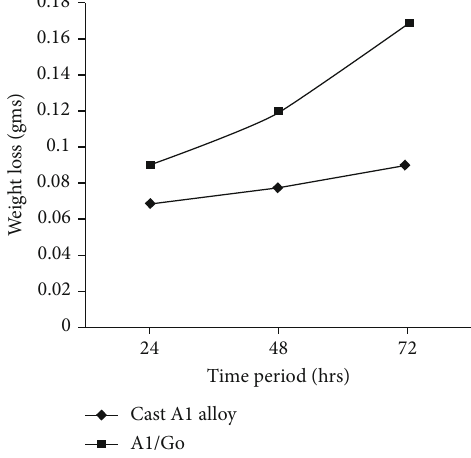
Figure 8: Weight loss of the Al/GO corrosion